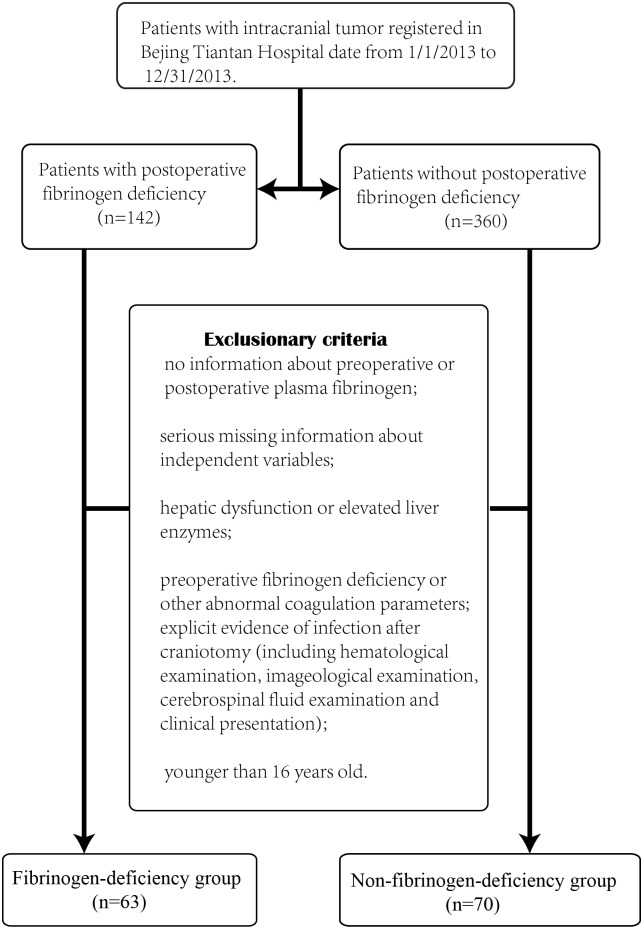
Exclusion criterion.